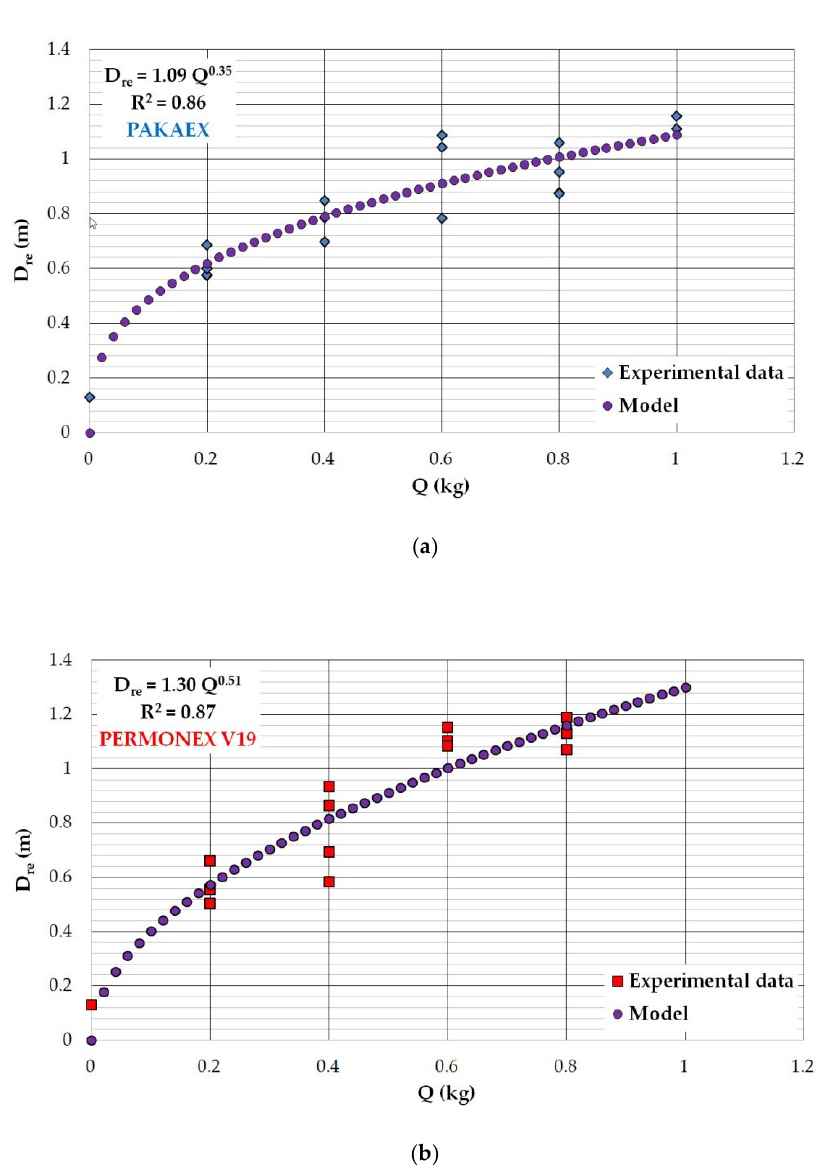
Figure 14. ( a ) The mathematical model plots of the lowest AIC c values for the expansion diameter D re (m) for Pakaex. ( b ) The mathematical model plots of the lowest AIC c values for the expansion diameter D re (m) for Permonex V19.